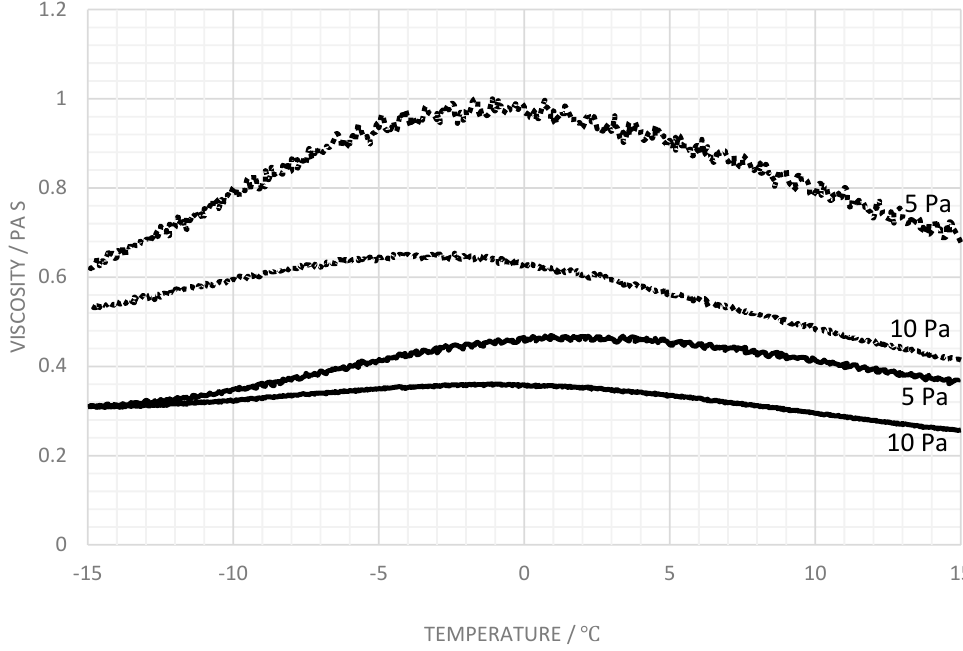
Figure 7. Viscosity variation for Carbomer A with 0.06% K + (A2K) (-) and 0.06% Na + (A2N) ( ··· ) at shear stresses of 5 and 10 Pa.